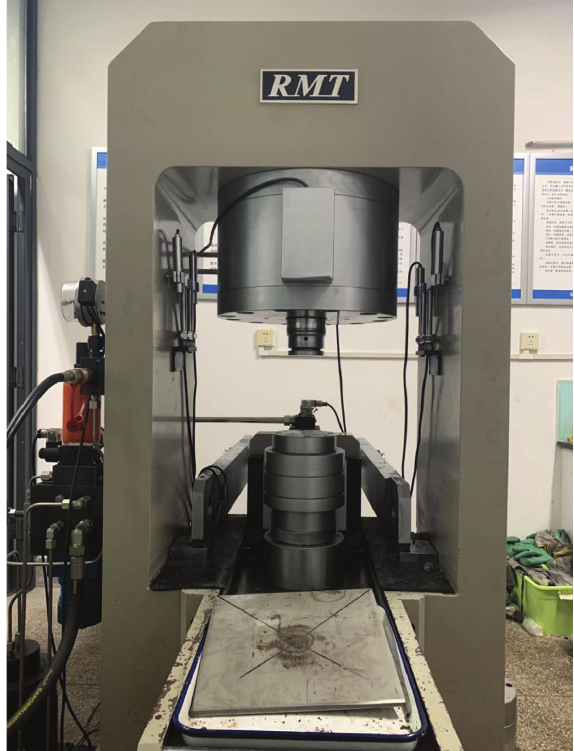
Figure 1: The RMT-150C rock mechanics test system.